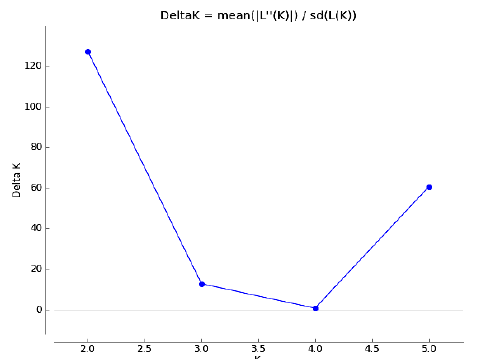
Figure 3. Results of the Bayesian assignment analysis using the Structure Harvester.